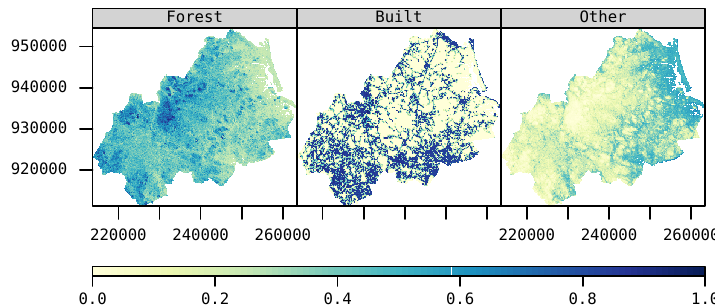
Figure 4. Suitability of pixels in the Plum Island Ecosystems study site to belong to forest, built and other land use classes according to binary logistic regression models. Elevation and slope are used as explanatory variables for all land uses while built additionally includes distance to built pixels in